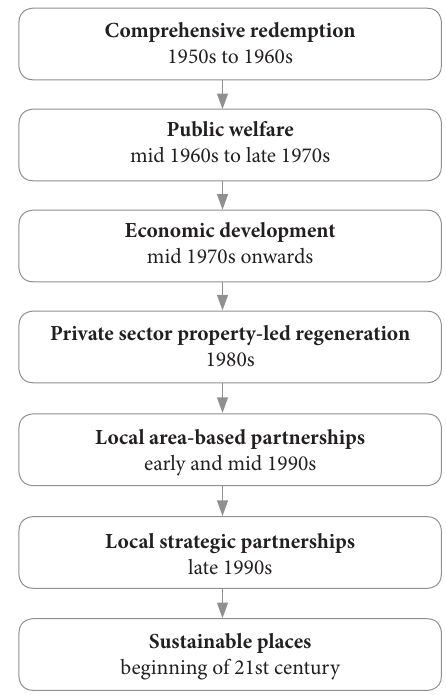
Fig. 1. Evolution of urban regeneration